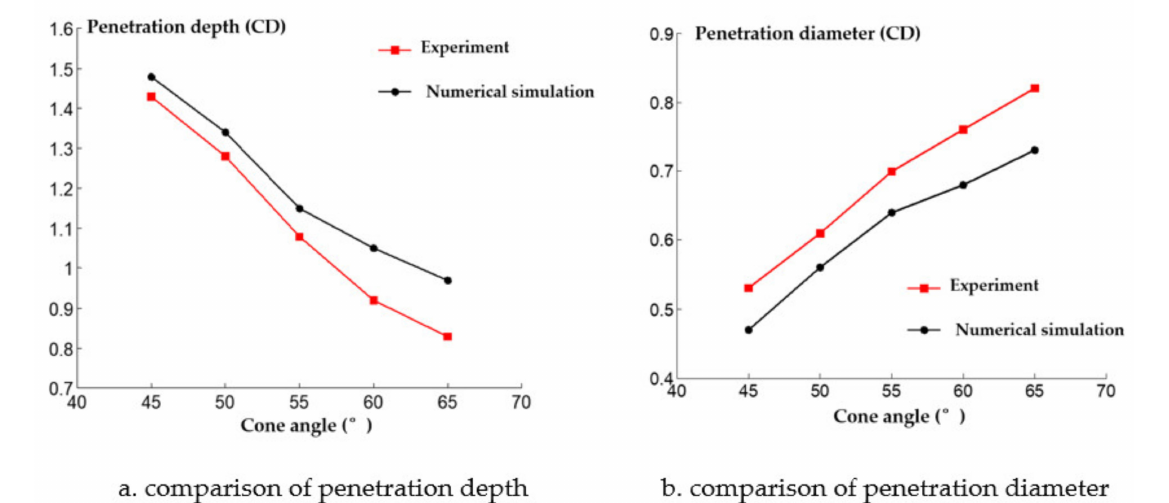
Figure 13. Comparison of numerical simulation and experimental results.